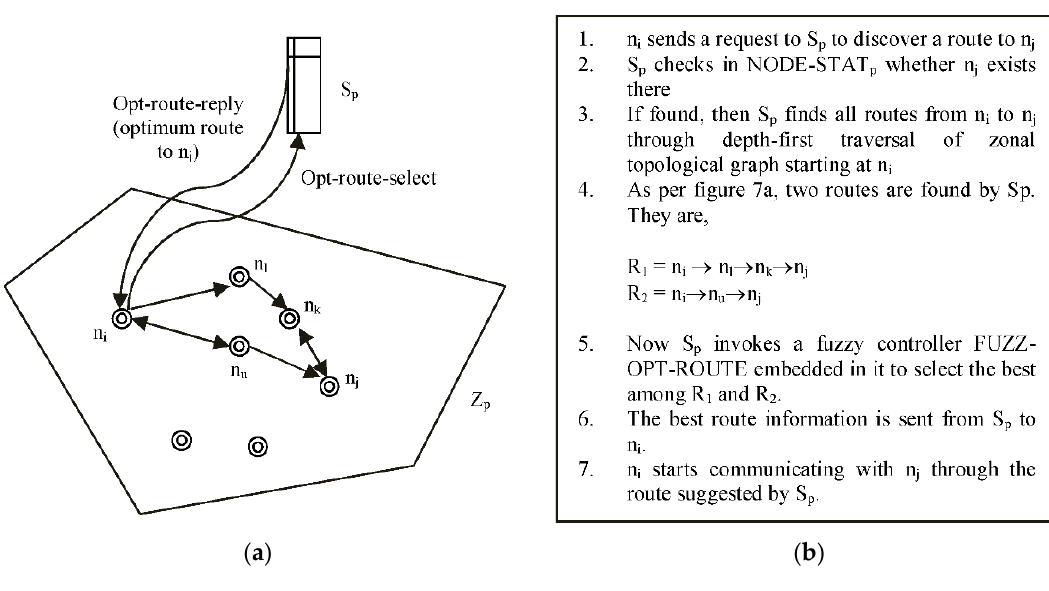
Figure 8. ( a )Source n i and destination n j are in same zone Z p ; ( b )optimum route selection by S p in Figure 8a.